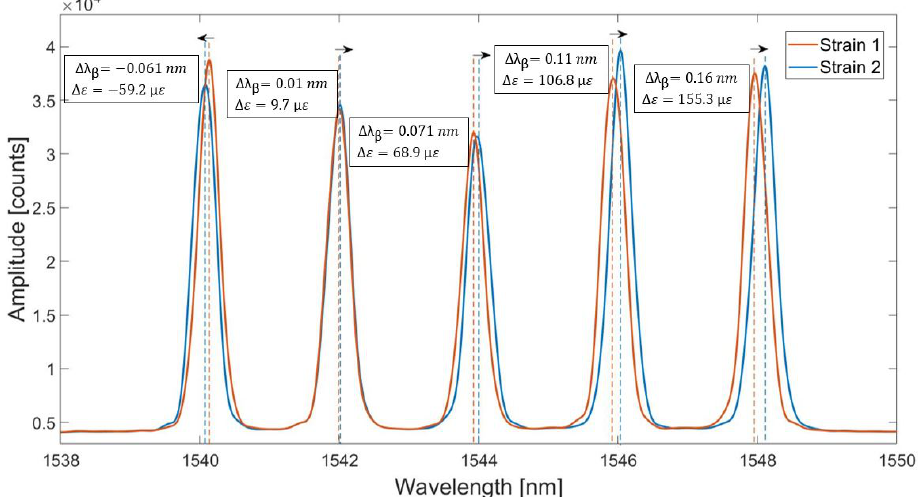
Figure 4. Reflection spectrum of the 5 FBGs array exposed to different strains (strain 1 and strain 2). The arrows shows the direction of the wavelength shifts for each FBG due to the strain applied to the array.